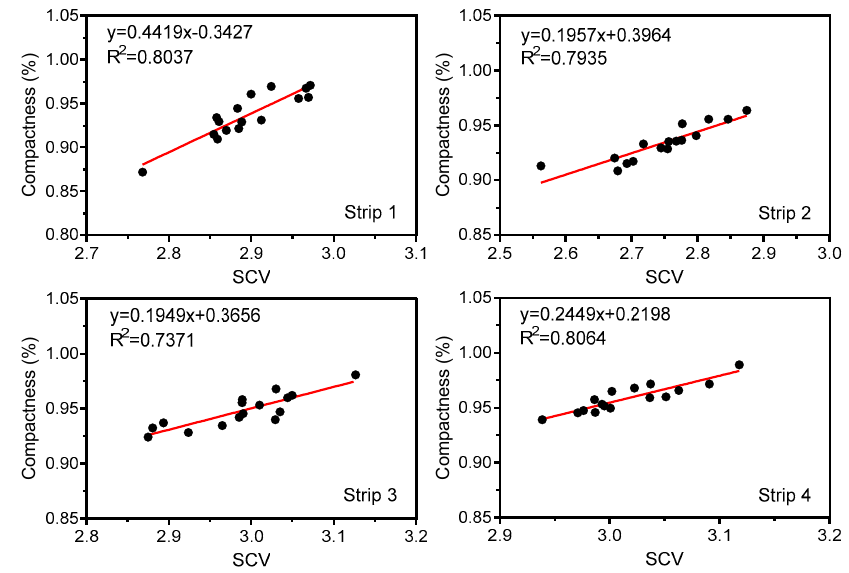
Figure 17. Linear correlations between SCV and compactness computed from all test strips.